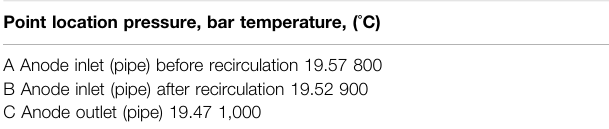
TABLE 8 | Operating conditions of the SOFC to assess the risk of carbon